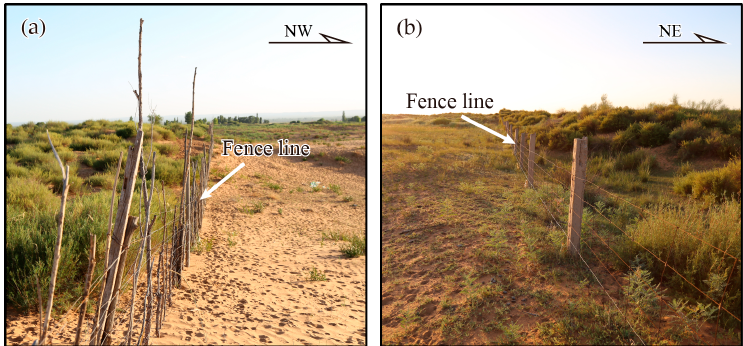
Figure 14. Photos showing the desertification expansion caused by stock breeding on the northwest ( a ) and southwest ( b ) of the fence line. Their locations are shown in Figure 13.